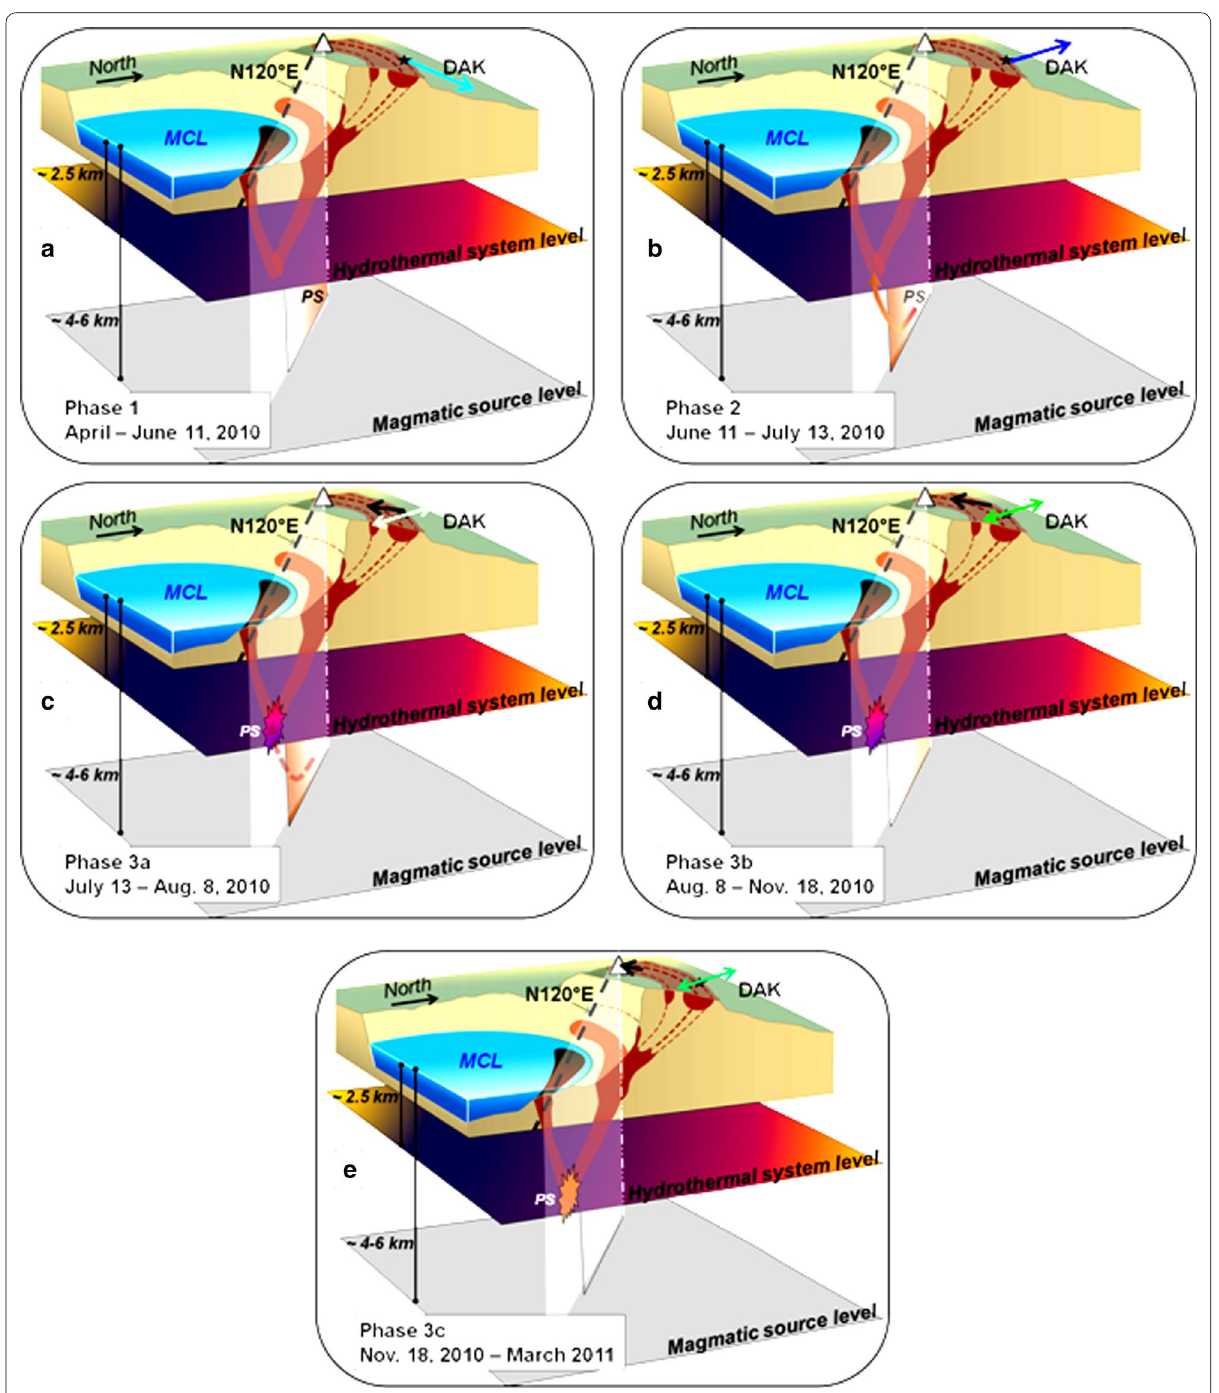
Fig. 11 Schematic interpretation of the dynamics and the source of deformation during the 2010 seismovolcanic crisis. a April to June 11. b June 11 to July 13. c July 13 to August 4–8. d August 8 to November 18. e November 18 to end of March